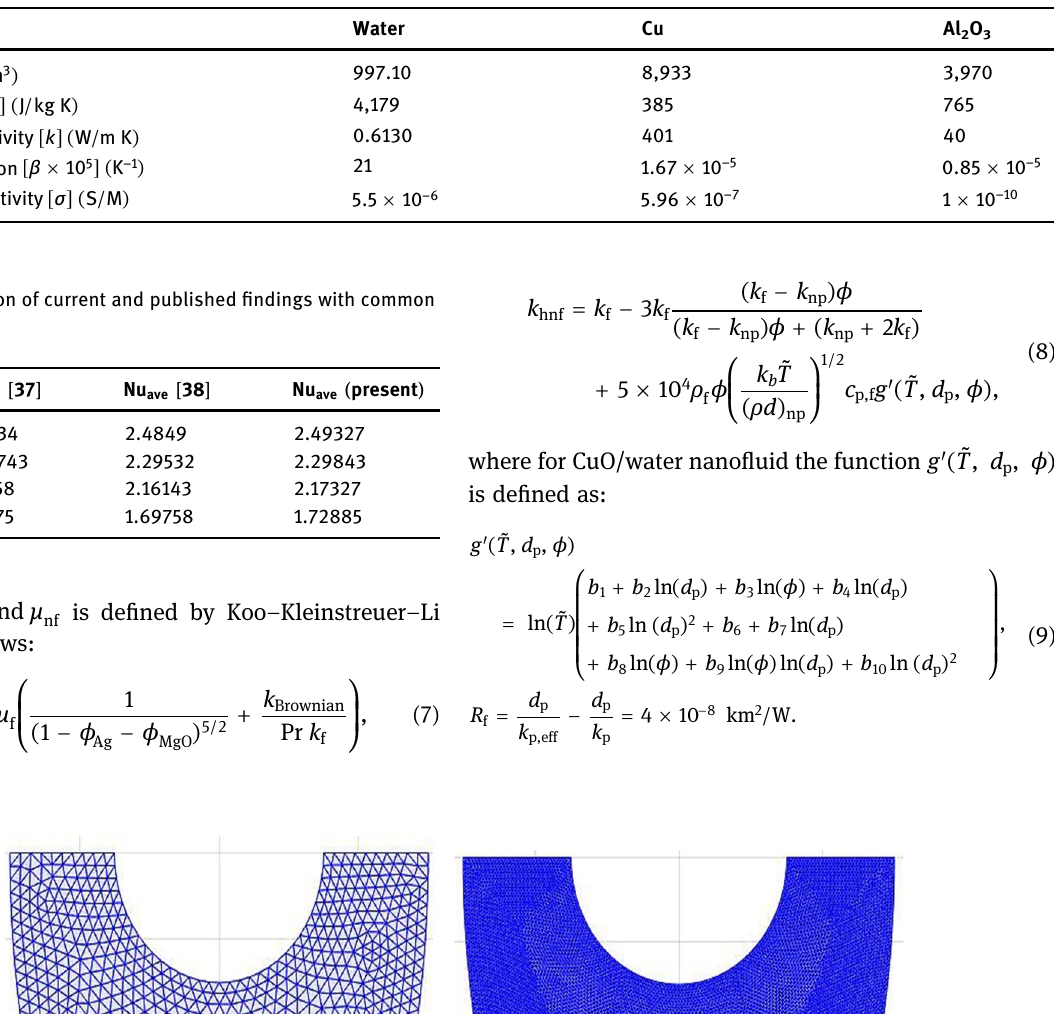
Table 1: Thermophysical properties of Cu and Al 2 O 3 nanoparticles [ 36 ]